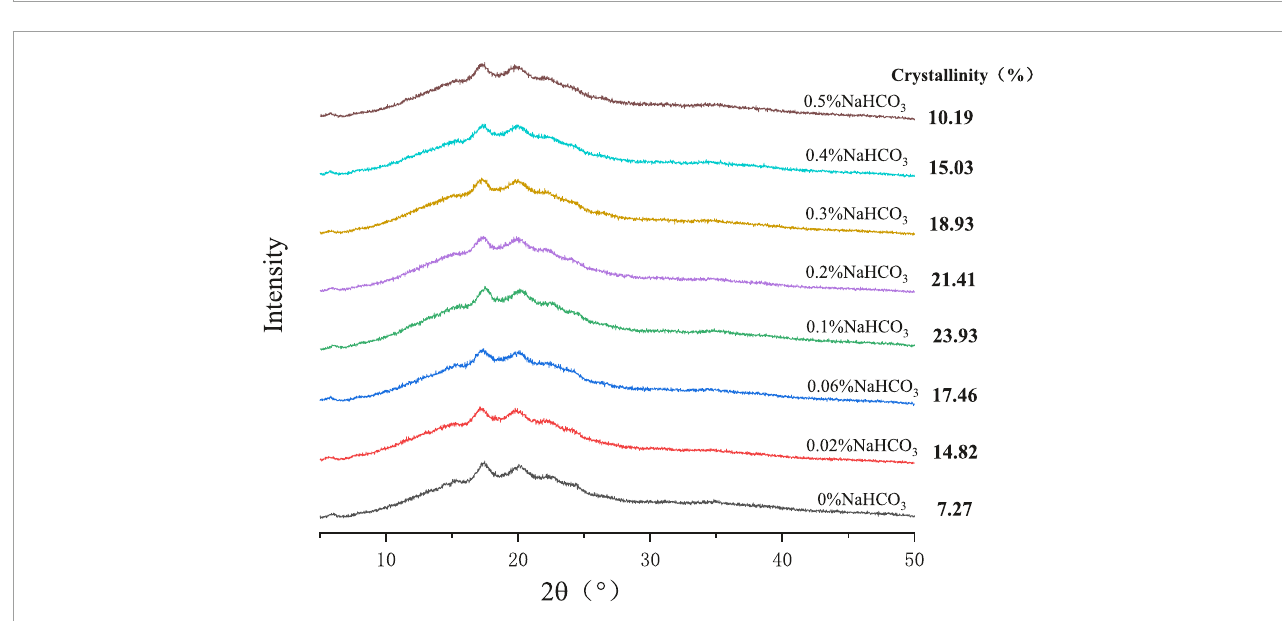
FIGURE4 Effect of sodium bicarbonate on the crystallinity of semi-dried rice